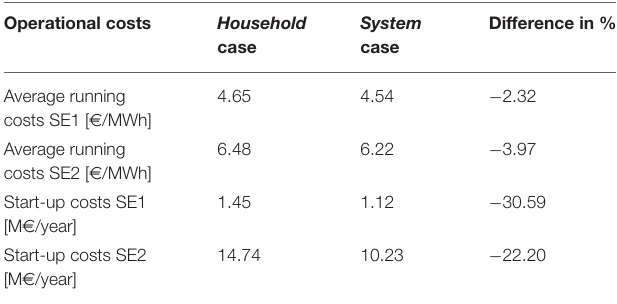
TABLE 4 | Cost comparison of the System and Household cases for Swedish operational costs, as obtained from modeling of the Green Policy scenario. Operational